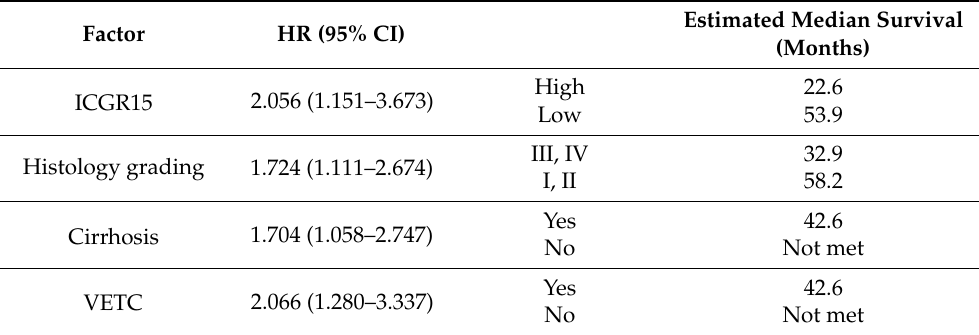
Table 3. Summary of the presence of VETC in HCC after resection for disease-free